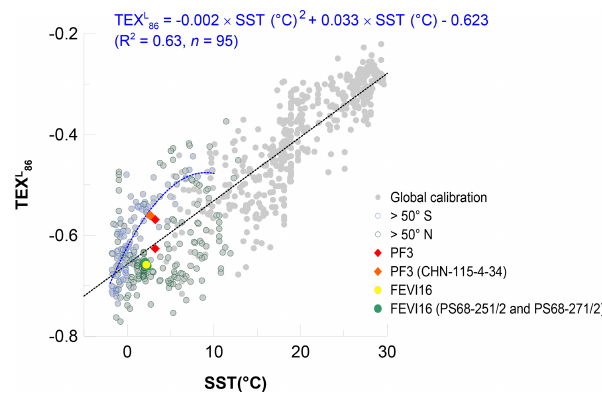
Figure 9. Correlation of TEX L values with mean annual SSTs in 86 the global ocean (gray symbols; Tierney and Tingley (2015) and ref- erence therein). Blue and black round symbols represent the high- latitude regions higher than 50 ◦ S and 50 ◦ N, respectively. In the southern regions ( > 50 ◦ S), TEX L values have a polynomial corre- 86 lation with maSSTs ( R 2 = 0 . 63, n = 95). Red and orange diamonds represent the flux-weighted mean TEX L of the two traps at the site 86 PF3 and TEX L on the surface sediment (CHN-115-4-34), respec- 86 tively. Yellow and green round symbols represent the flux-weighted mean TEX L at the site FEVI16 and TEX L on the surface sedi- 86 86 ments (PS68-251/2 and PS68-271/2),